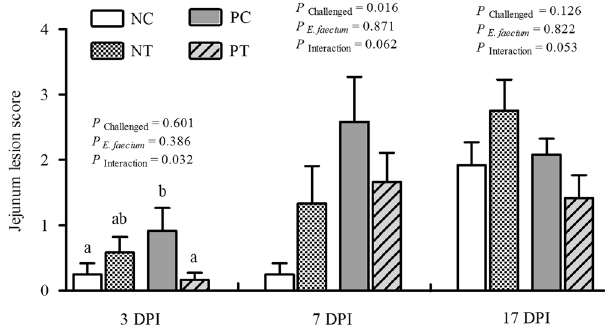
Figure 3. Effect of dietary E . faecium 11181 on lesion scores in the jejunum of broiler chickens challenged with NE. Values are means (n = 6) with the standard error of the mean (SEM) represented by vertical bars. The lowercase letters on the bars indicate significant differences ( P < 0.05). NC = Non-NE-infected + no E. faecium treatment, NT = non-NE-infected + E. faecium treatment, PC = NE-infected + no E. faecium treatment, PT = NE-infected + E. faecium